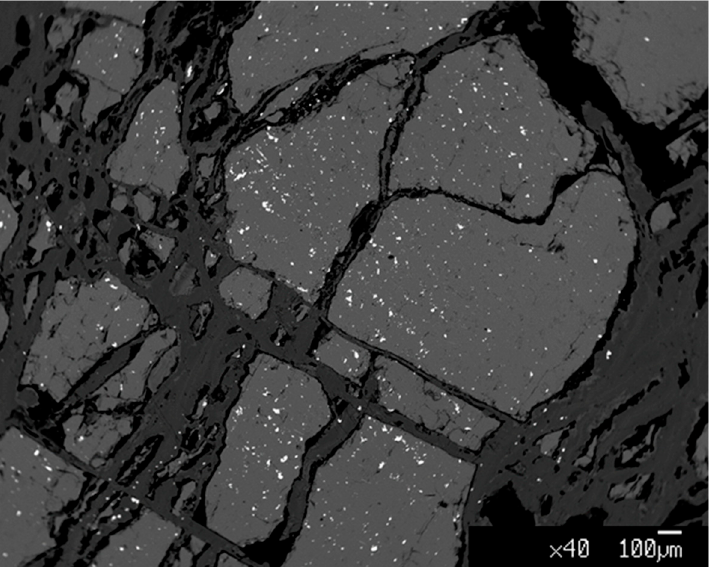
Figure 11. Back scattered electron (BSE) image from sample W5 showing Fe inclusions (white) in olivine relics into serpentine matrix.